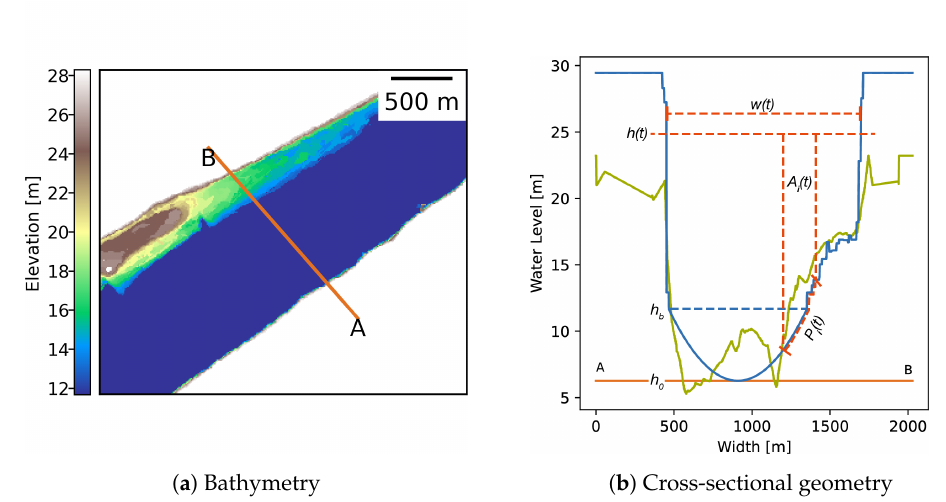
Figure 5. Constructed bathymetry ( a ) within the AOI and extracted cross-sectional geometry ( b ) with geometric parameters downstream of Vicksburg at CS 694.7. The solid blue line in ( b ) shows the estimated cross-sectional profile and the green line the bathymetric survey data as reference. The dashed blue line shows the observed baseflow h b and the solid orange line the estimated river bed elevation h 0 . A i ( t ) is the area of subsection i defined by the water level h ( t ) at the top and the wetted perimeter P i ( t ) at the